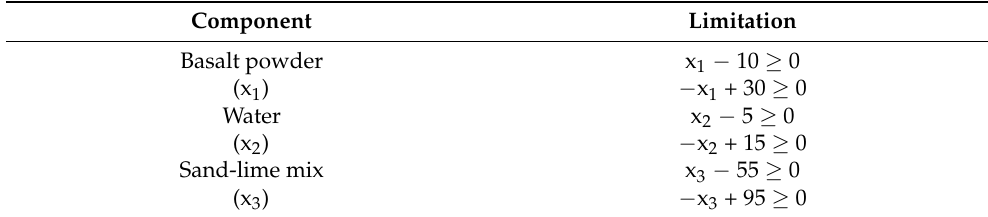
Table 2. Restrictions on the content of individual components in the raw material mass. Component